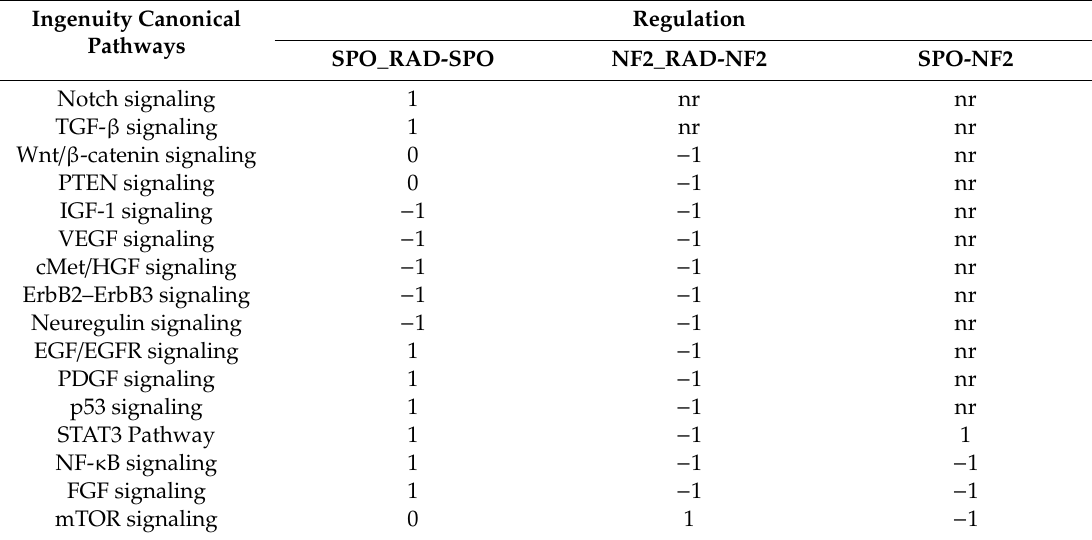
Table 2. Important deregulated signaling pathways after irradiation of sporadic and neurofibromatosis type 2 (NF2)-associated tumors versus